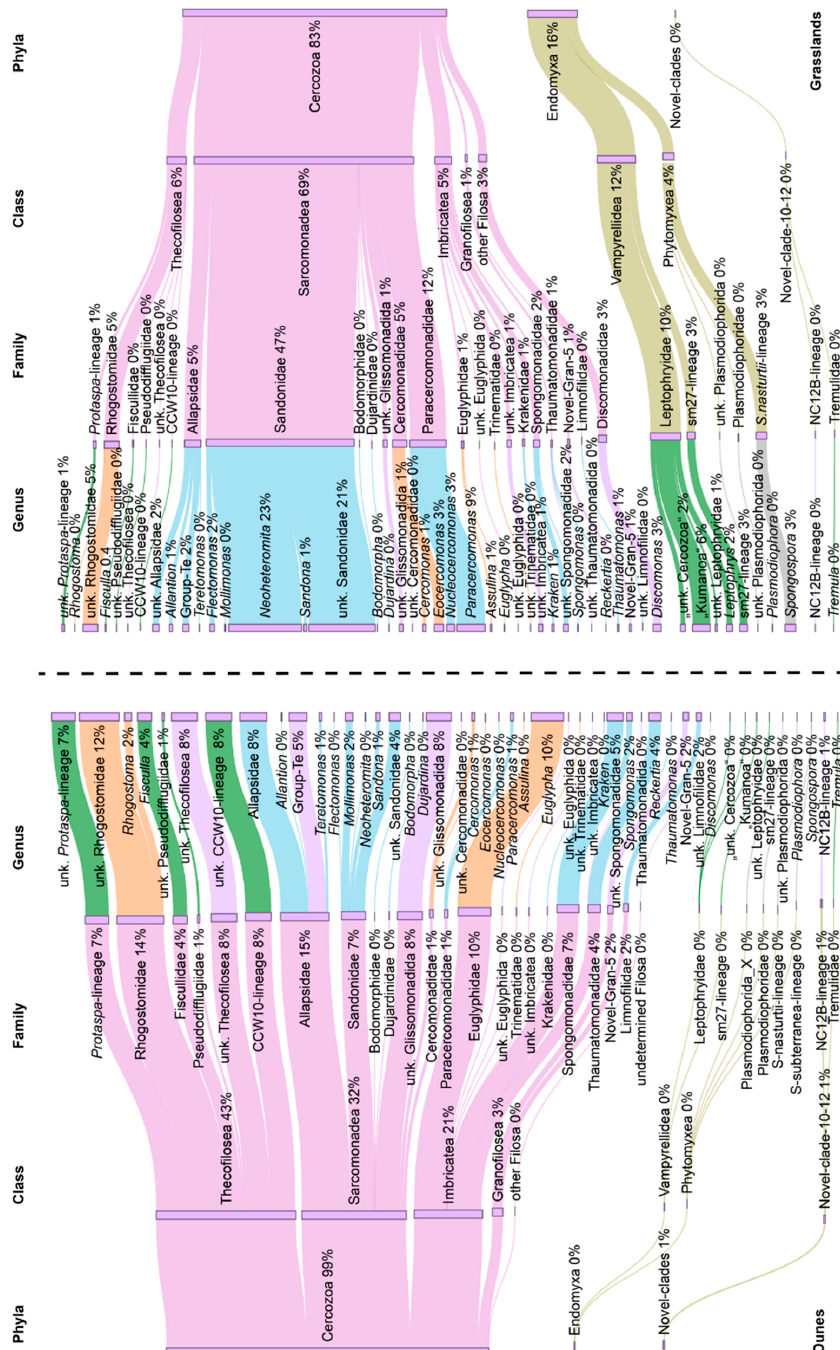
Figure 1. Sankey diagram based on the relative abundance of the operational taxonomic units (out) reads in biocrust samples from Germany (on the left ) and Iceland (on the right ). Taxonomical assignment was based on the best hit by BLAST. “Undetermined” refers to sequences that could either not be assigned to the next lower-ranking taxon or made up less than 1% of cercozoan diversity. At the genus level, the functionality (feeding behavior) of Cercozoa and Endomyxa is shown by color codes; blue color refers to bacterivores; sandy brown to omnivores; green to eukaryvores; gray to plant parasites; sequences that could not be assigned to taxa with known traits are shown in purple. Omnivorous and eukaryvorous Cercozoa include potential and known algivores.